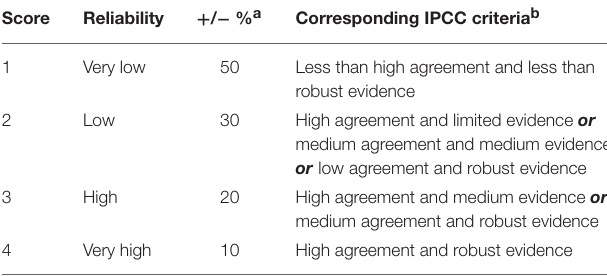
TABLE 2 | Scoring system for evaluating the quality and reliability of time series of reconstructed catches, for deriving uncertainty (reliability) bands for reconstructed